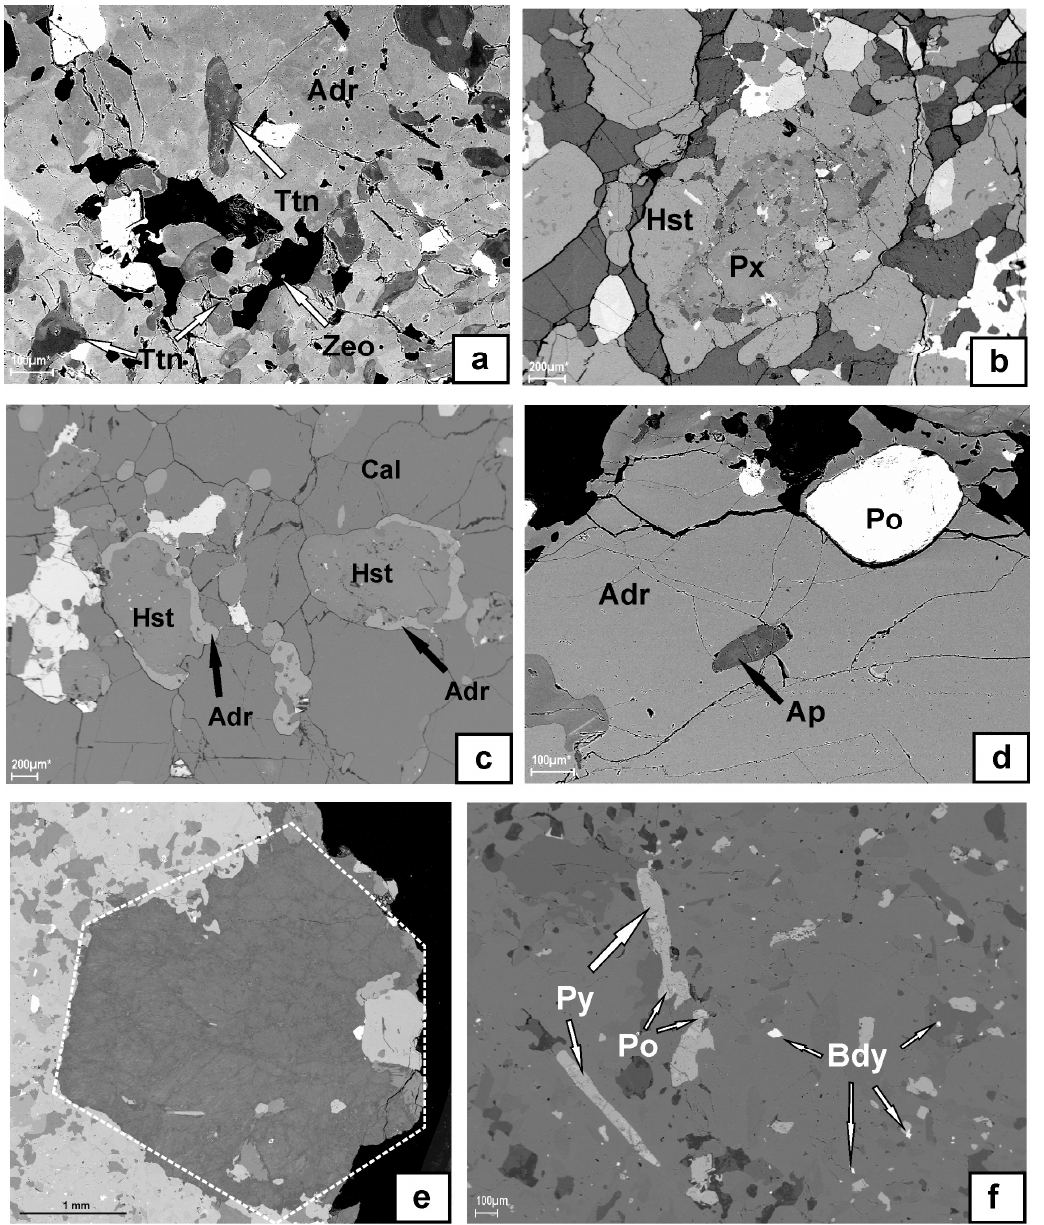
Figure 2. Back-scattered-electron (BSE) images showing the relationships between different minerals in the Breivikbotn carbonatite: ( a ) titanite, zeolite and magnetite (brightest) included in andradite; ( b ) hastingsite rimming pyroxene; ( c ) andradite rim around hastingsite, calcite grains show typical triple junctions; ( d ) apatite and pyrrhotite included in andradite; ( e ) roughly hexagonal habit of zeolite aggregate; ( f ) inclusions of accessory pyrite, pyrrhotite and baddeleyite in andradite. Mineral abbreviations are from [23].